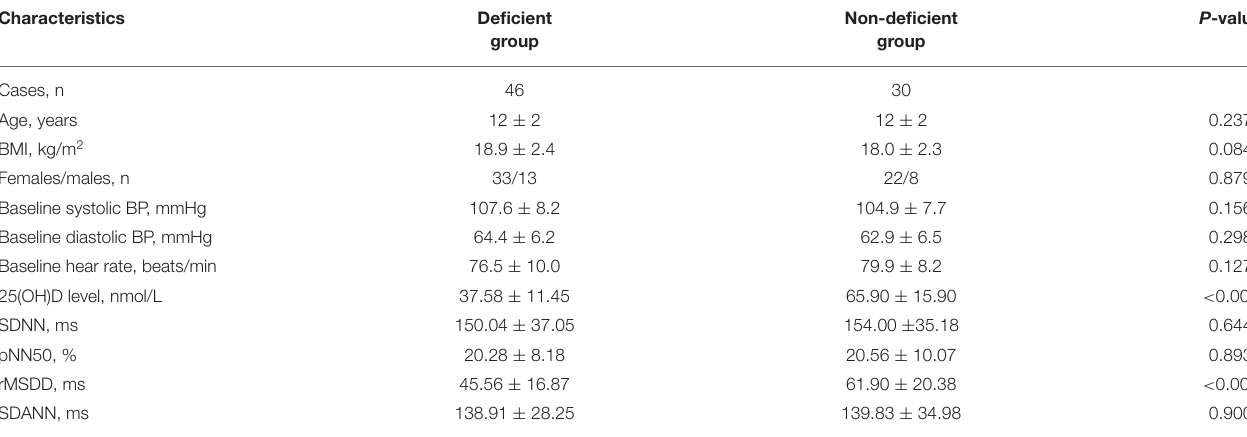
TABLE 2 | Characteristics and HRV indices of time-domain analysis in children and adolescents with VVS based on 25-hydroxyvitamin D status.